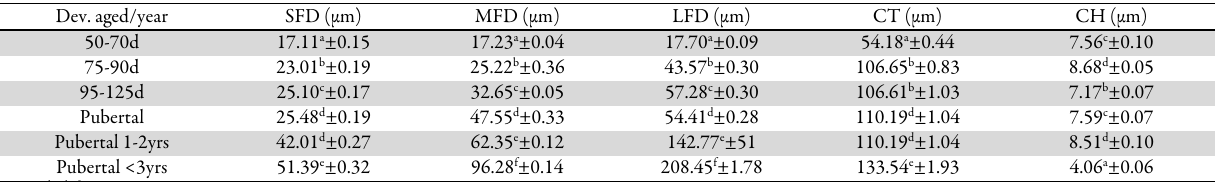
Table 1. The West African dwarf goat thyroid histometry Dev.